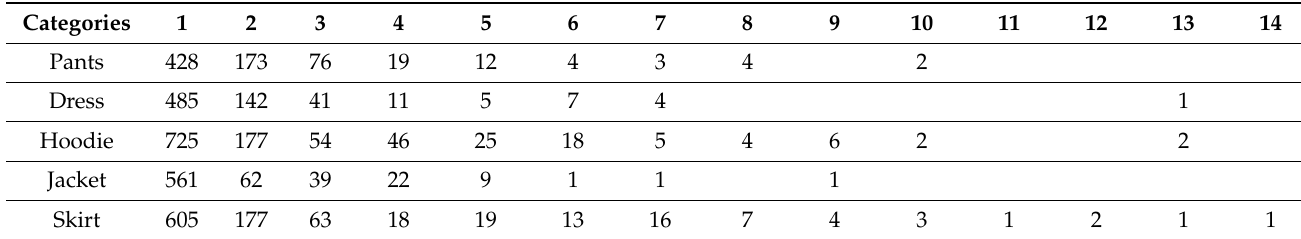
Table 2. The number of images according to the bounding boxes per category.